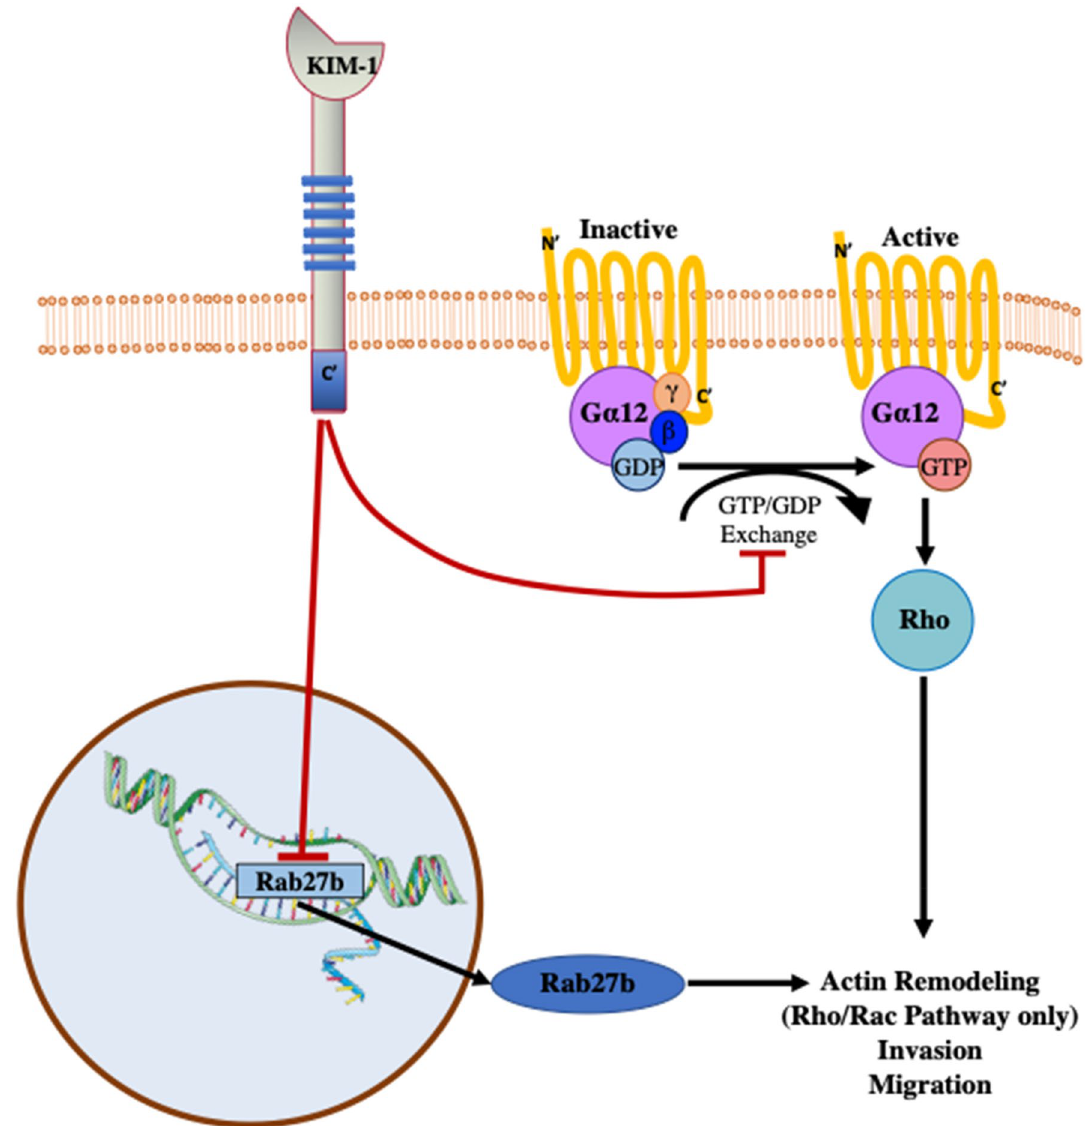
Figure 6. Schematic representation of the potential interaction between KIM-1 and the Rho signaling pathway in RCC cells. KIM-1 expression on RCC cells constrictively binds and inhibits Gα12 activation by blocking GTP-exchange 4 . Inactivation of Gα12 results in downstream inhibition of the small GTPase Rho which has been implicated in promoting the progression and migration of a variety of cancer cells 5,6 . Schematic representation of proposed effects how KIM-1 expression inhibits transcription of pro-metastatic Rab27b, possibly inhibiting protein effects such as invasion and metastasis of RCC